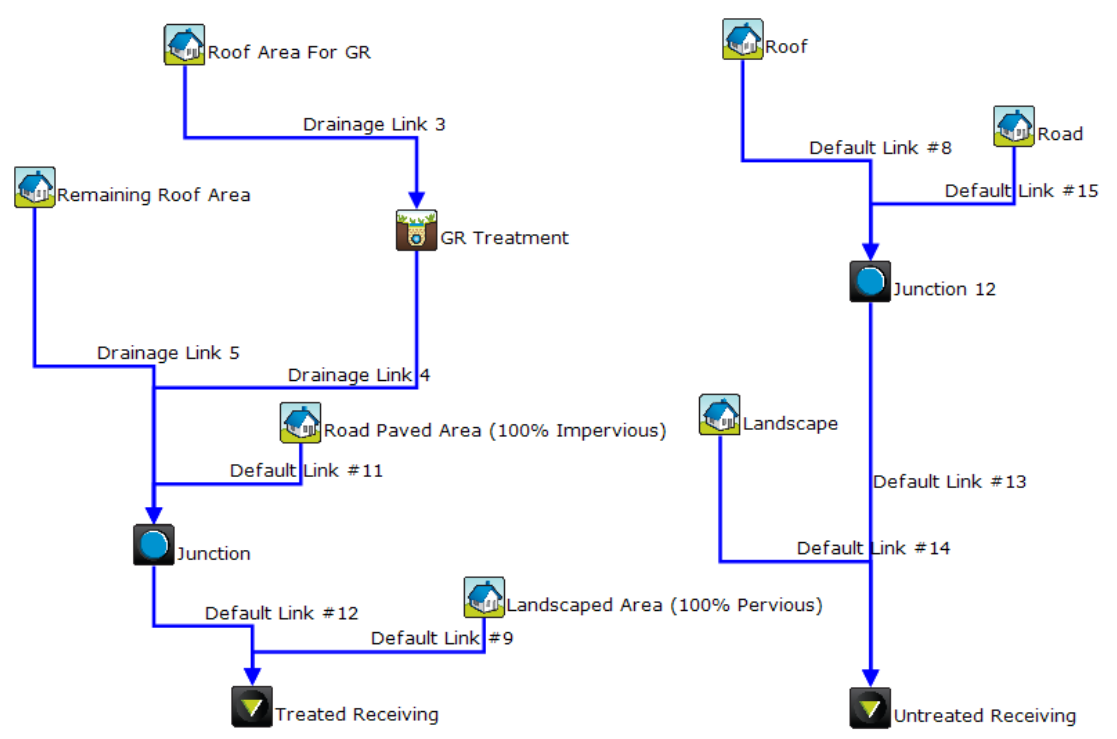
Figure 8. MUSIC schematic of green roof modeling using the bioretention node .